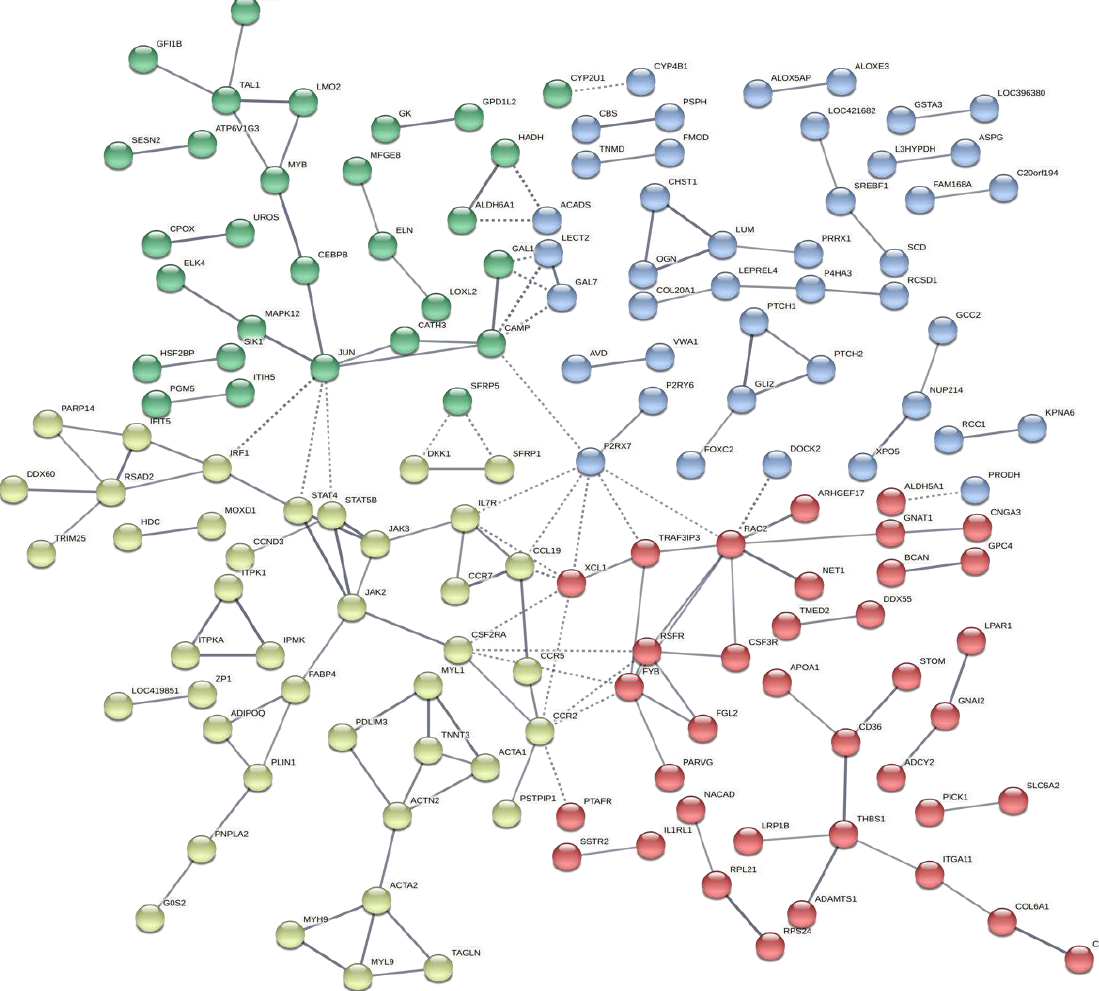
Figure 8. Gene network constructed using the Stringdb with DE genes and genes with SNPs differing between control and affected groups. The line thickness indicates the strength of data support. The circles represent genes, and different colors represents group of genes with similar functions or acting in similar